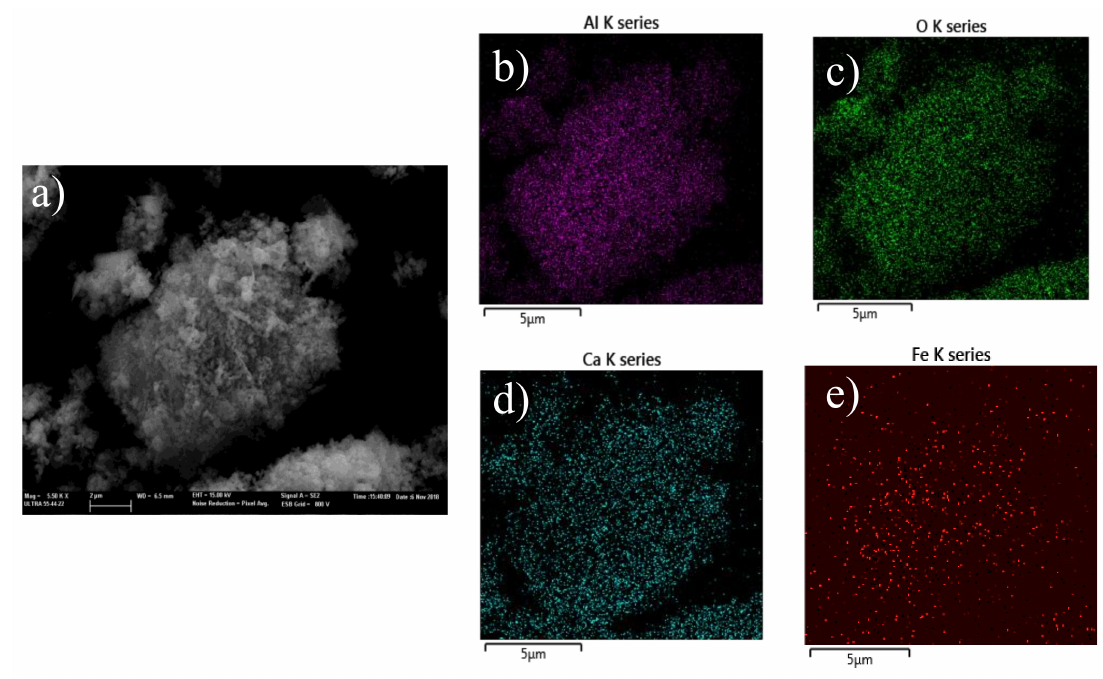
Figure 2. ( a ) FESEM micrograph (magnification of × 5500) of Fe / mayenite; atomic mapping of Fe / mayenite: ( b ) Al (purple); ( c ) O (green); ( d ) Ca (blue); ( e ) Fe